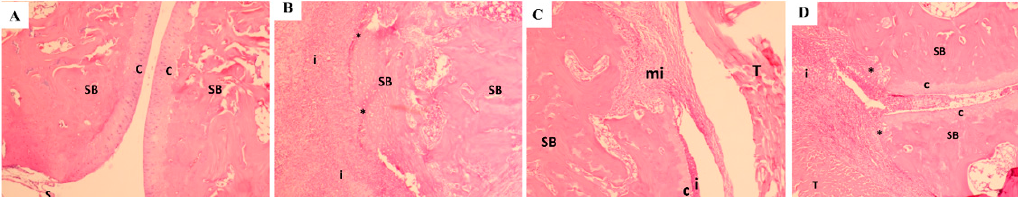
Figure 12. Microscopic changes in HE staining: ( A ). Normal Control + Vehicle: HE 50 × –Histology of the hock with minimal pathology. SB–subchondral bone (pink), C–cartilage (purple), S–synovium; ( B ). CIA + Vehicle: 50X HE: Inflammation (i) and diffuse necrosis of the subchondral bone (SB) with effacement of the articular surfaces (*). There is complete loss of the bone architecture; ( C ). CIA + Methotrexate: 50 × -HE–These images demonstrate an area of fibroplasia with monocytic inflammation (mi). SB–subchondral bone, C–cartilage with adhered inflammation (i), T–Tendon; ( D ). CIA + UP1306: 50 × HE–Subchondral bone (SB) with the overlying cartilage (c) and adjacent bone being effaced (*) by inflammation; (i) T–tendon expanded by edema and infiltrated by inflammation.